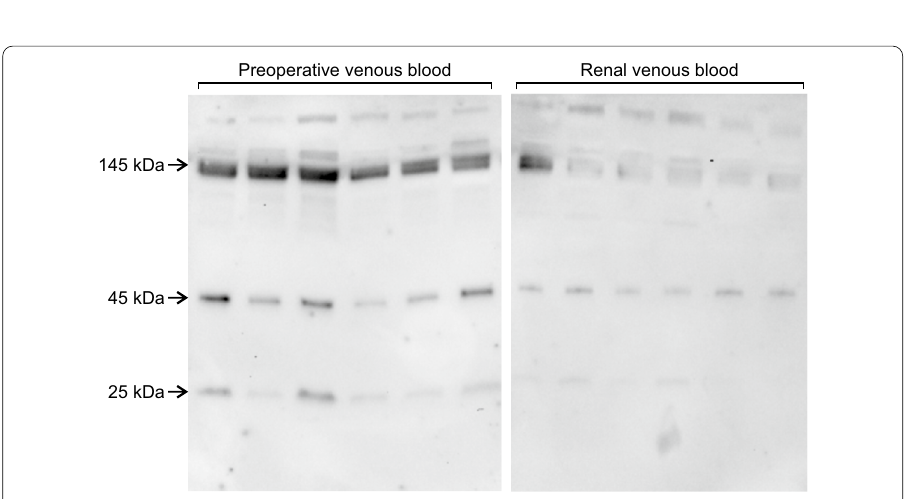
Fig. 3 Representative Western-blots of neutrophil gelatinase-associated lipocalin (NGAL) isoforms in six patients. Left panel shows the Western blots of NGAL in preoperative venous blood of six consecutive patients. Right panel shows Western blots of NGAL of the same patients in renal venous blood at 2 minutes after reperfusion of the kidney graft